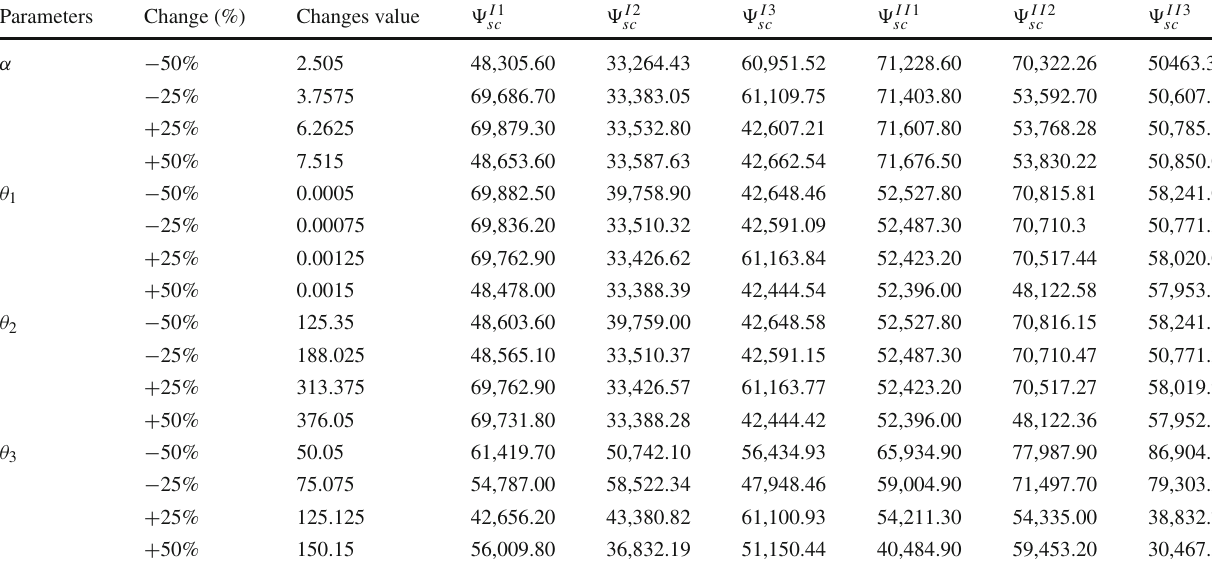
Table 11 Parameters changes value versus joint supply chain profit in different cases